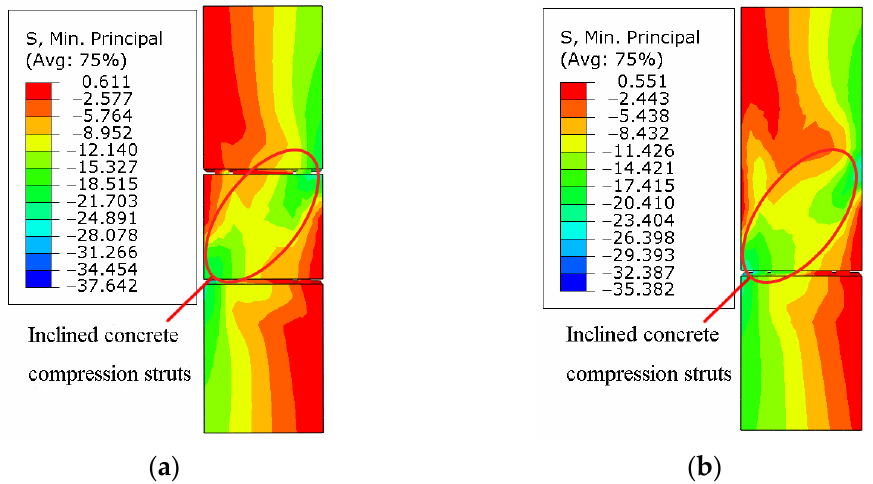
Figure 16. Principal compressive stress σ 3 contours of the concrete in connection zone at the yield